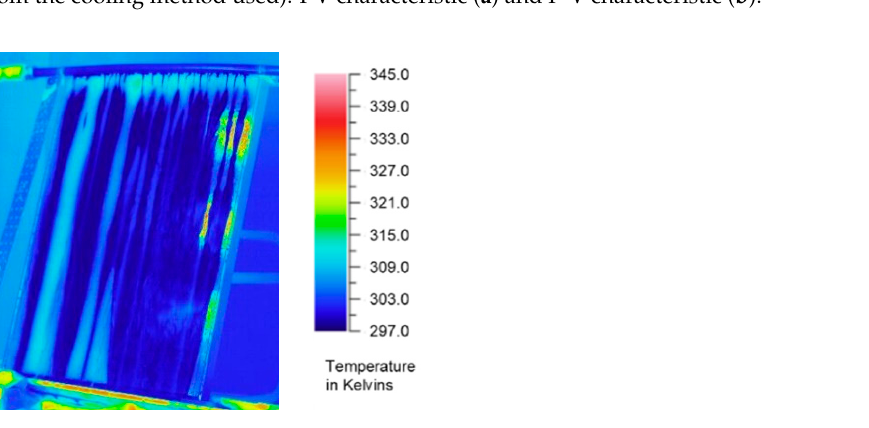
Figure 9. Variations in the performance of the 50 Wp PV panel depend on its temperature (resulted from the cooling method used): I-V characteristic ( a ) and P-V characteristic ( b ).